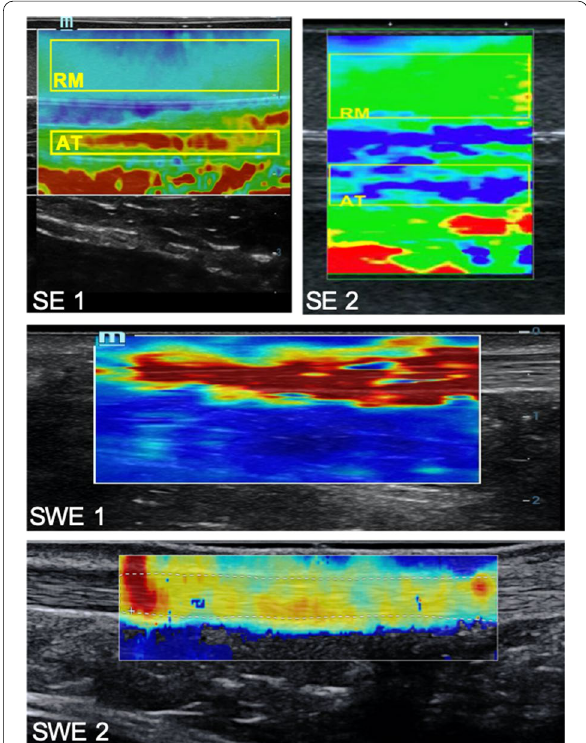
Fig. 2 Example of the Achilles tendon mechanical properties at 0 kg measured with the different sonoelastography devices. SE1, strain elastography Resona 7, Mindray; SE2, strain elastography Aplio 500, Toshiba Medical Systems Corp.; SWE1, shear wave elastography Resona 7, Mindray; SWE2, shear wave elastography Aixplorer; SuperSonic Imagine, RM, reference material; AT, Achilles tendon